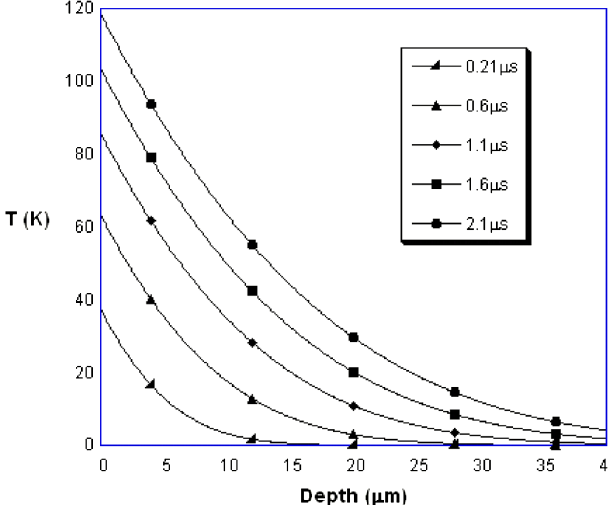
3. Elevated temperature profiles at five time